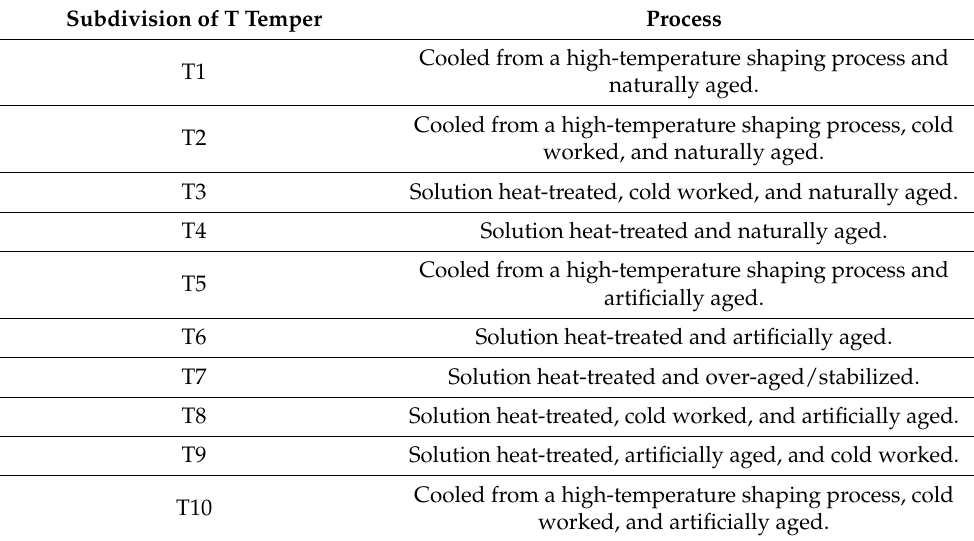
Table 3. Subdivision of T temper of aluminum alloys. Adapted from [10].